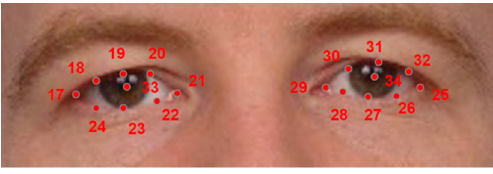
Figure 20. The landmarks from the IMM face database denoting the eye region.